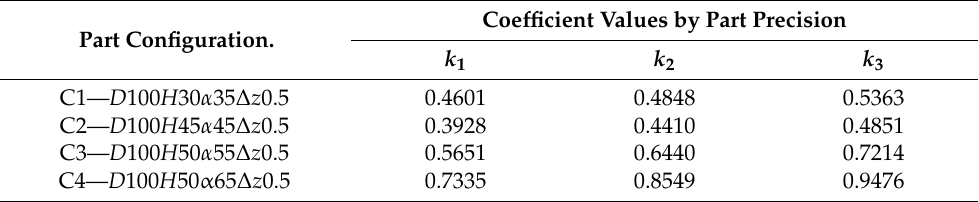
Table 4. Coefficients k 1 , k 2 and k 3 for all configurations, reprinted with permission from ref. [5]. Part Configuration.